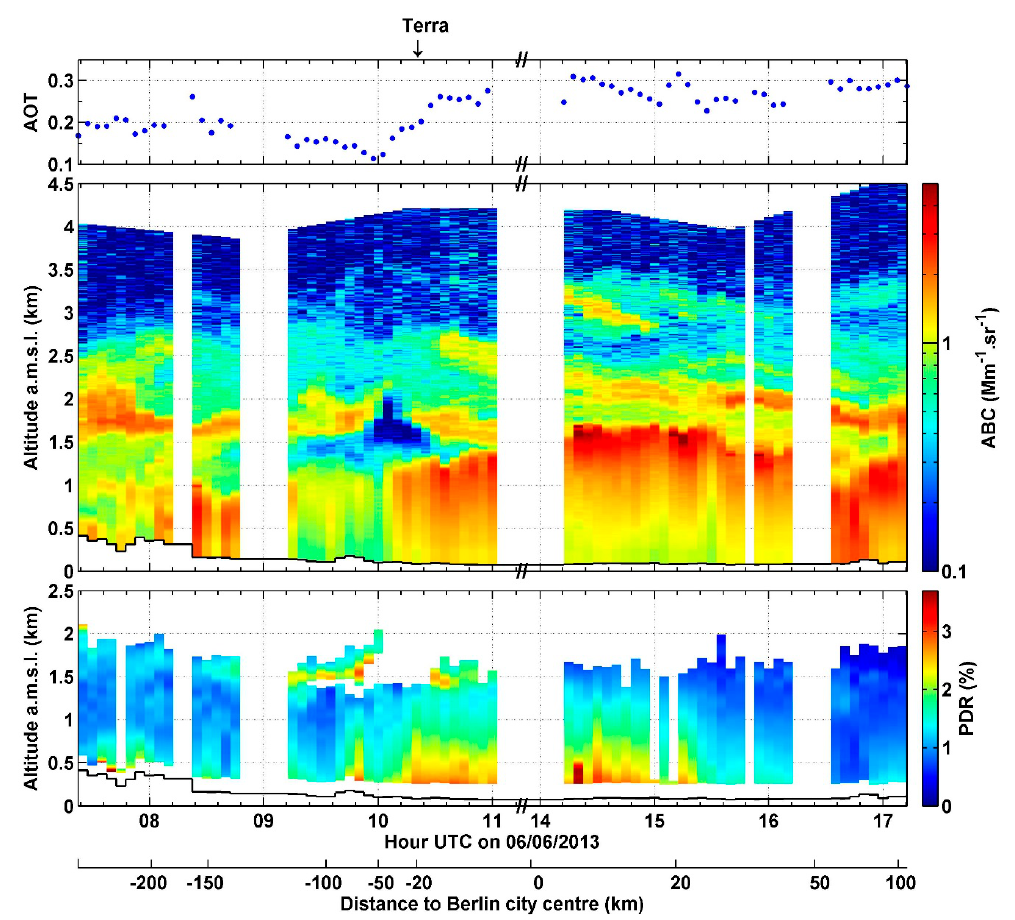
Figure 5. Same as Figure 4 but in Eastern Germany and above Berlin on Thursday 6 June 2013. The 5-min average profiles are inverted using the LR value retrieved from a lidar/MODIS synergy (Terra overpass time is indicated over the AOT plot). The point used to compute the distance from the city center is Brandenburg Gate; negative (positive) distances are west (east) of Berlin. Local time is UTC+2.